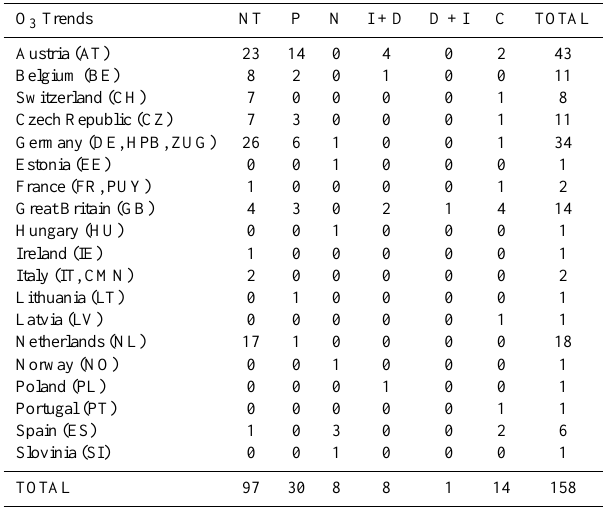
Fig. 6. The deviation from the 1996-2005 inclusive European- averaged annual trend in mean, 5 th and 95 th percentiles when indi- vidual years are excluded from analysis